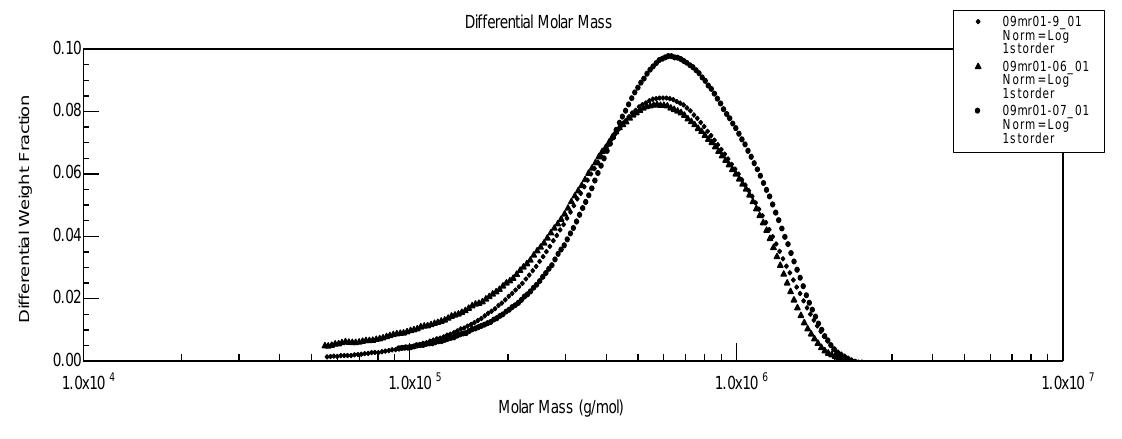
Figure 3. Influence of pre-traitement on molecular weight distribution of pure hyaluronan. ▲ Initial linear HA; ● linear HA stored at 4°C; ♦ HA after freezing at –21